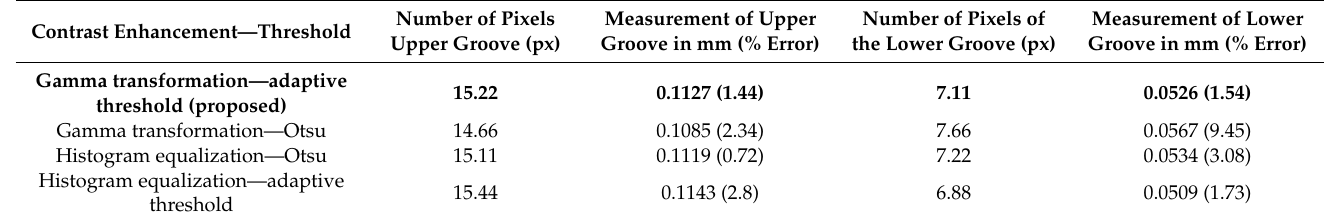
Table 5. Comparison of groove measurements and errors using different contrast enhancements and